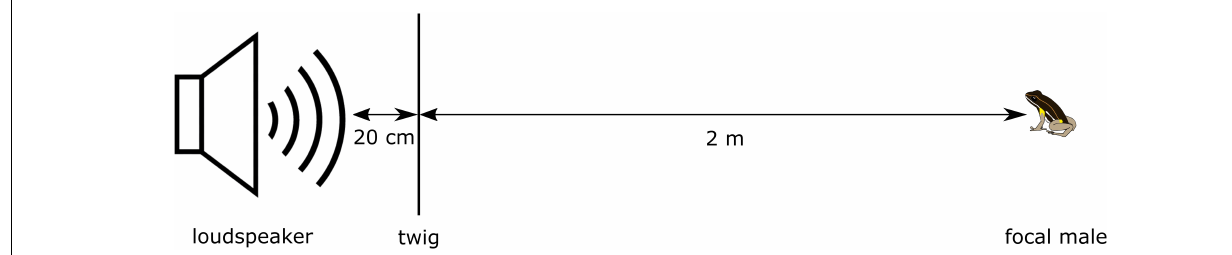
FIGURE 1 | Experimental setup to assess individual aggressiveness of territorial A. femoralis males.